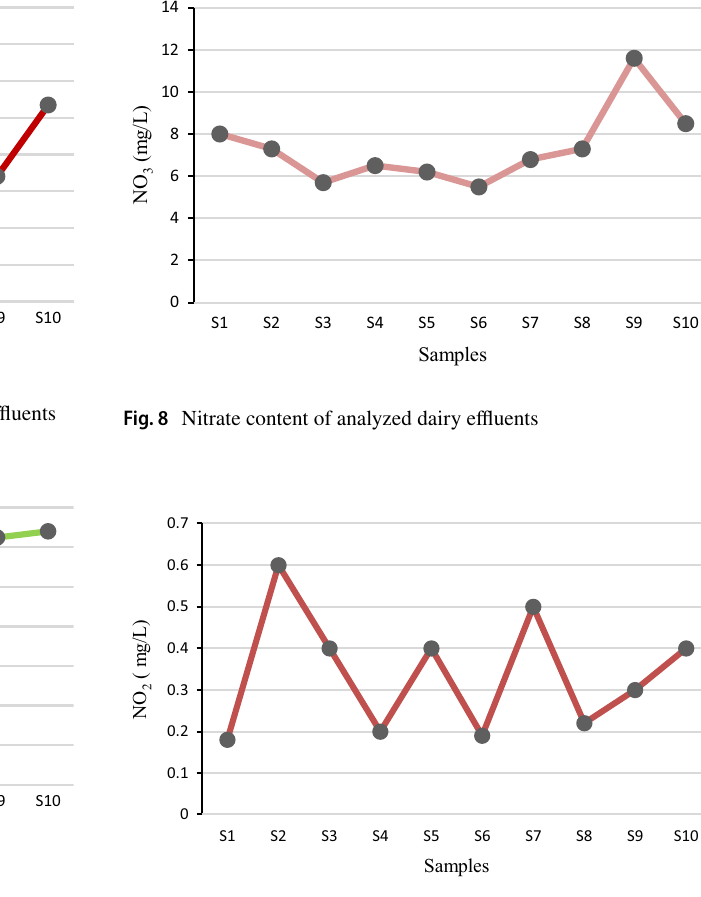
Fig. 9 Nitrite content of analyzed dairy